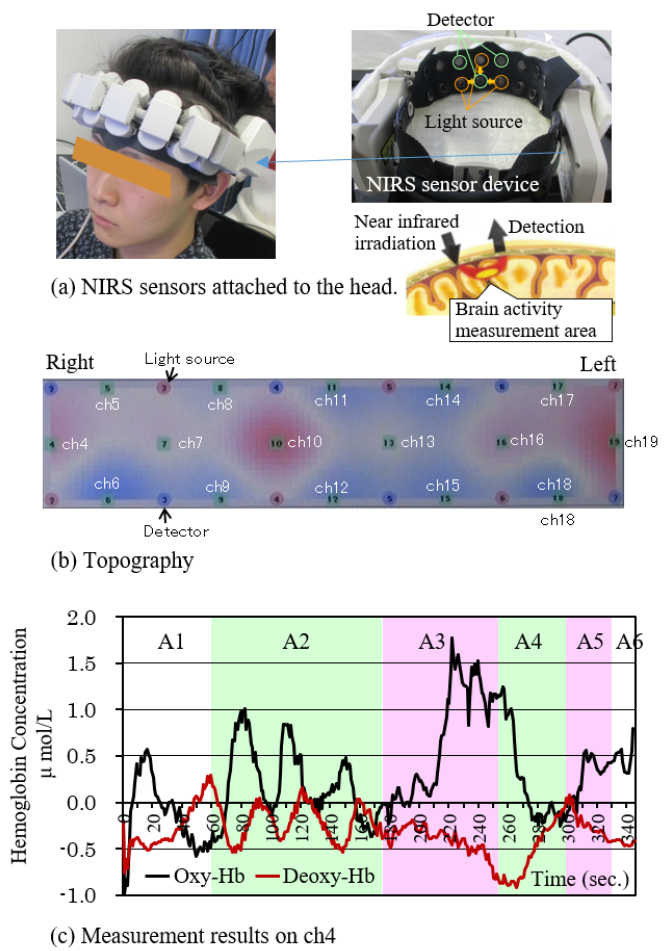
Figure 11. Example of multichannel NIRS results while viewing the content.